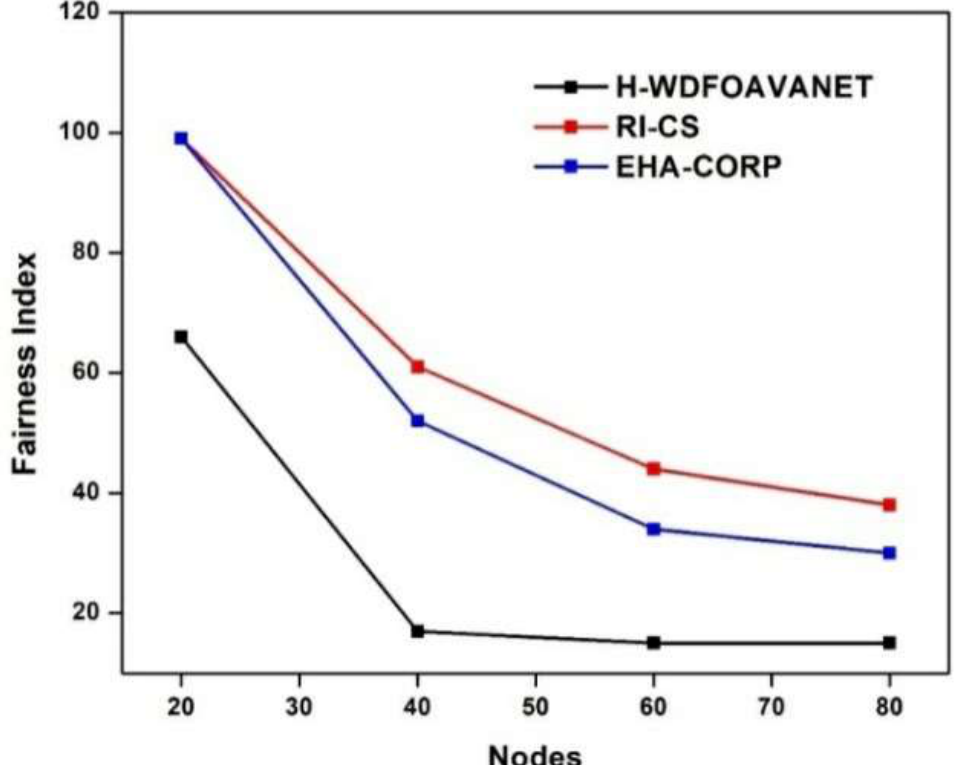
Figure 18. Plots of nodes vs. fairness index in the suggested approach and existing approaches.